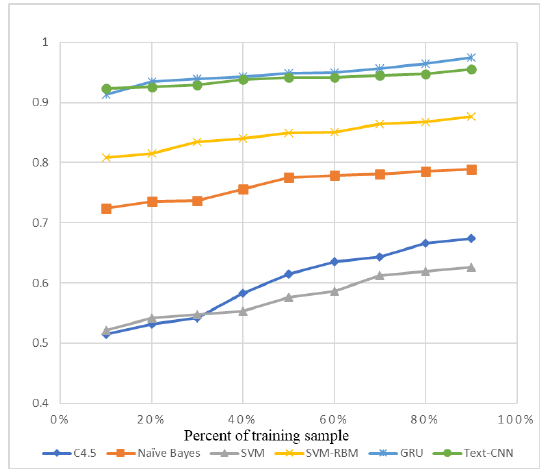
Figure 7. F1-Score of KDD99-Normal.